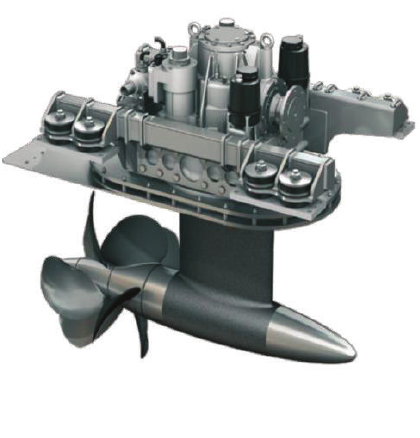
Figure 1: ZF 4000 Large Pod, using contrarotating propellers designed with the presented